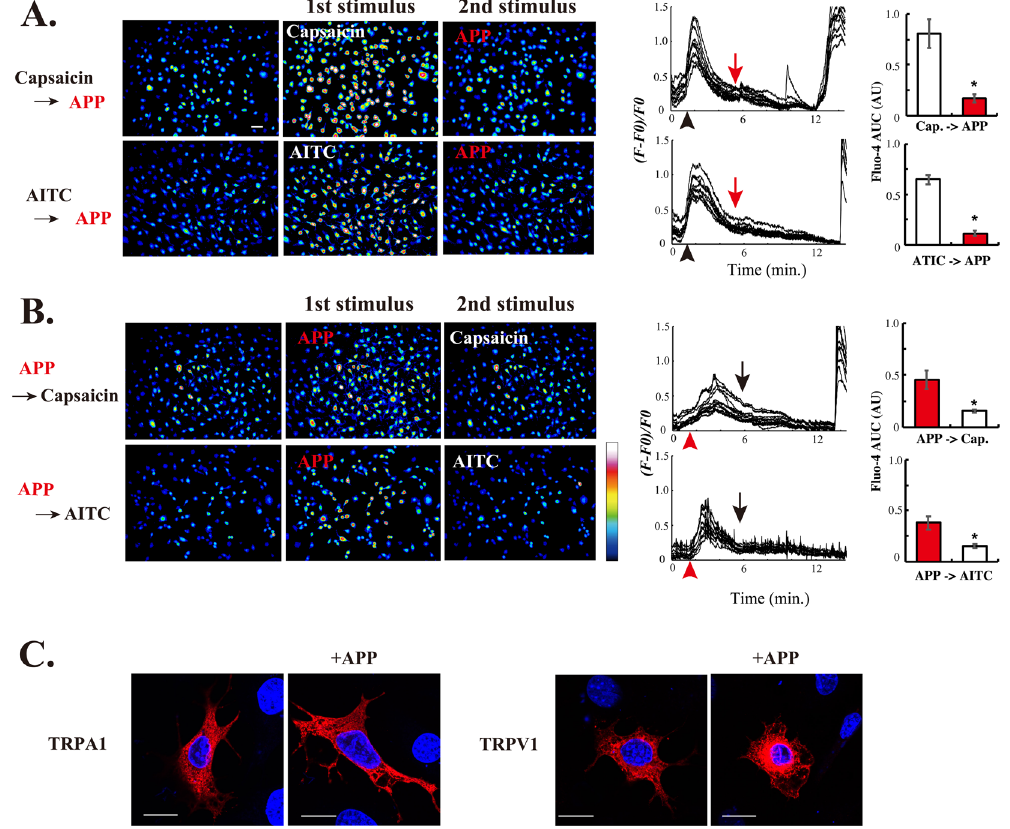
Figure 2. Heterologous desensitization of the indirect APP-responsive [Ca 2 + ] i transients in 3T3L1 cells. ( A ) Pseudo-color images showing [Ca 2 + ] i elevation in 3T3L1 cells stimulated sequentially with either capsaicin or AITC as the 1 st stimulus and then with APP-exposed HBS as the 2 nd stimulus. The graphs on the right are representative single-cell traces of Fluo-4 fluorescence from the images on the left, expressed as (F − F0 )/ F0 . Capsaicin or AITC was applied at approximately 1 min. (black arrowheads), and 2.5 mL of APP-HBS were then applied at ~6 min. (red arrows) by infusion. AUC of the (F − F0 )/ F0 values of the 1st stimulus (1–5 min.) and the 2 nd stimulus (6–10 min.) are also shown. Scale bar = 100 μ m. Statistical significance was determined, versus the 1 st stimulus, by the Dunnett’s test. These are representative results obtained from three independent experiments. ( B ) Pseudo-color images showing [Ca 2 + ] i elevation in 3T3L1 cells stimulated sequentially with APP-HBS as the 1 st stimulus and then with capsaicin or AITC as the 2 nd stimulus. The pseudo-color coding on the right shows Fluo-4 fluorescence intensity. Graphs on the right are representative single-cell traces of Fluo-4 fluorescence from the images on the left, expressed as (F − F0 )/ F0 . APP-HBS was applied at approximately 1 min. ( red arrowheads ), and then capcaisin (3 μ M) or AITC (100 μ M) was administrated at ~6 min. ( black arrows ) by infusion. AUC of the (F − F0 )/ F0 values of the 1st stimulus (1–5 min.) and the 2 nd stimulus (6–10 min.) are also shown. Statistical significance was determined, versus the 1 st stimulus, by the Dunnett’s test. The results shown are representative of three independent experiments. ( C ) Subcellular localization of Halo-TRPA1 and TRPV1-Halo in 3T3L1 fibroblasts exogenously expressing either Halo-TRPA1 or TRPV1- Halo stimulated with or without APP-HBS for 5 min. The images shown are representative of three independent experiments. Scale bar = 20 μ